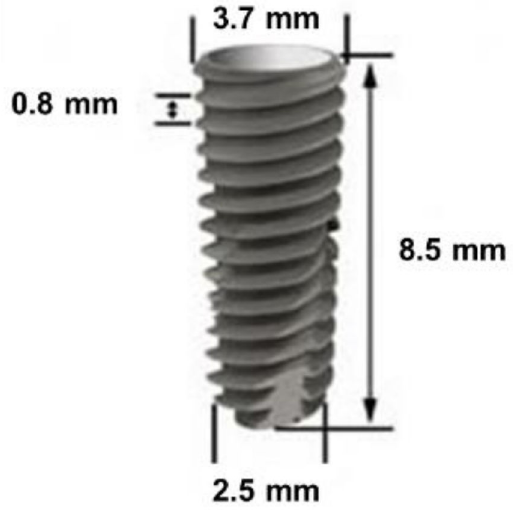
Figure 1. Design of implant fixture used in this study.